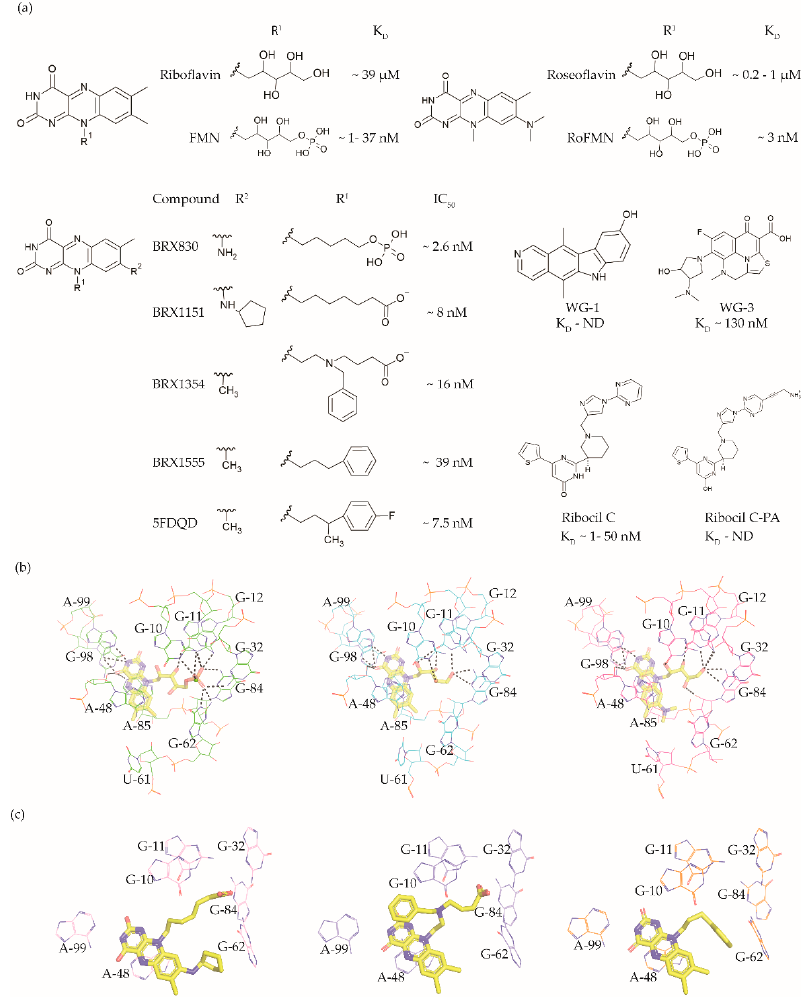
Figure 3. FMN riboswitch ligands. ( a ) Chemical structures of the FMN riboswitch ligands together with K D or IC 50 values taken from various studies [34,61–64]. ( b ) The binding pocket of the FMN riboswitch in complex with FMN (PDB ID: 3F2Q, left), riboflavin (PDB ID: 3F4G, middle) and ro- seoflavin (PDB ID: 3F4H, right). The polar contacts are shown as black dotted lines and the magne- sium ion as a green sphere. ( c ) The binding poses of various ligands within the FMN riboswitch binding pocket—BRX1151 (PDB: 6DN1, pink), BRX1354 (PDB: 6DN2, blue), and BRX1555 (PDB: 6DN3, orange).